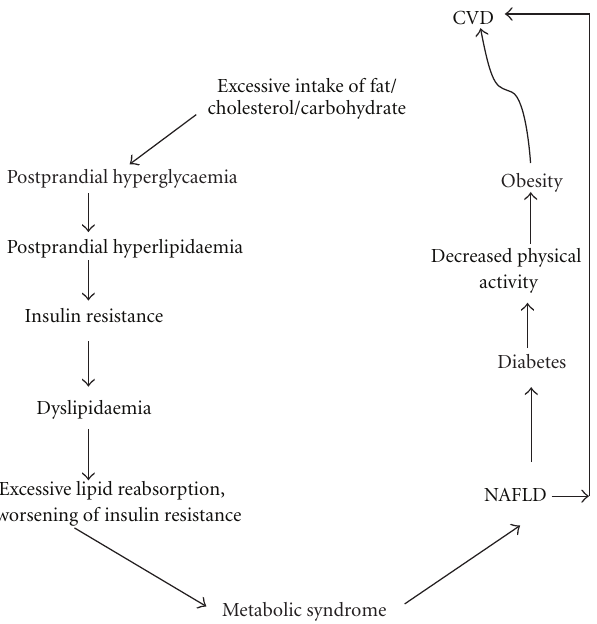
Figure 2: The metabolic cycle is an attempt to encompass traditional and emerging risk factors of CVD associated with NAFLD in one paradigm. The metabolic cycle is also an attempt to provide possible explanation why complex metabolic factors may lead to development of risk of CVD associated with NAFLD. In addition NAFLD per se can be associated with increased risk of